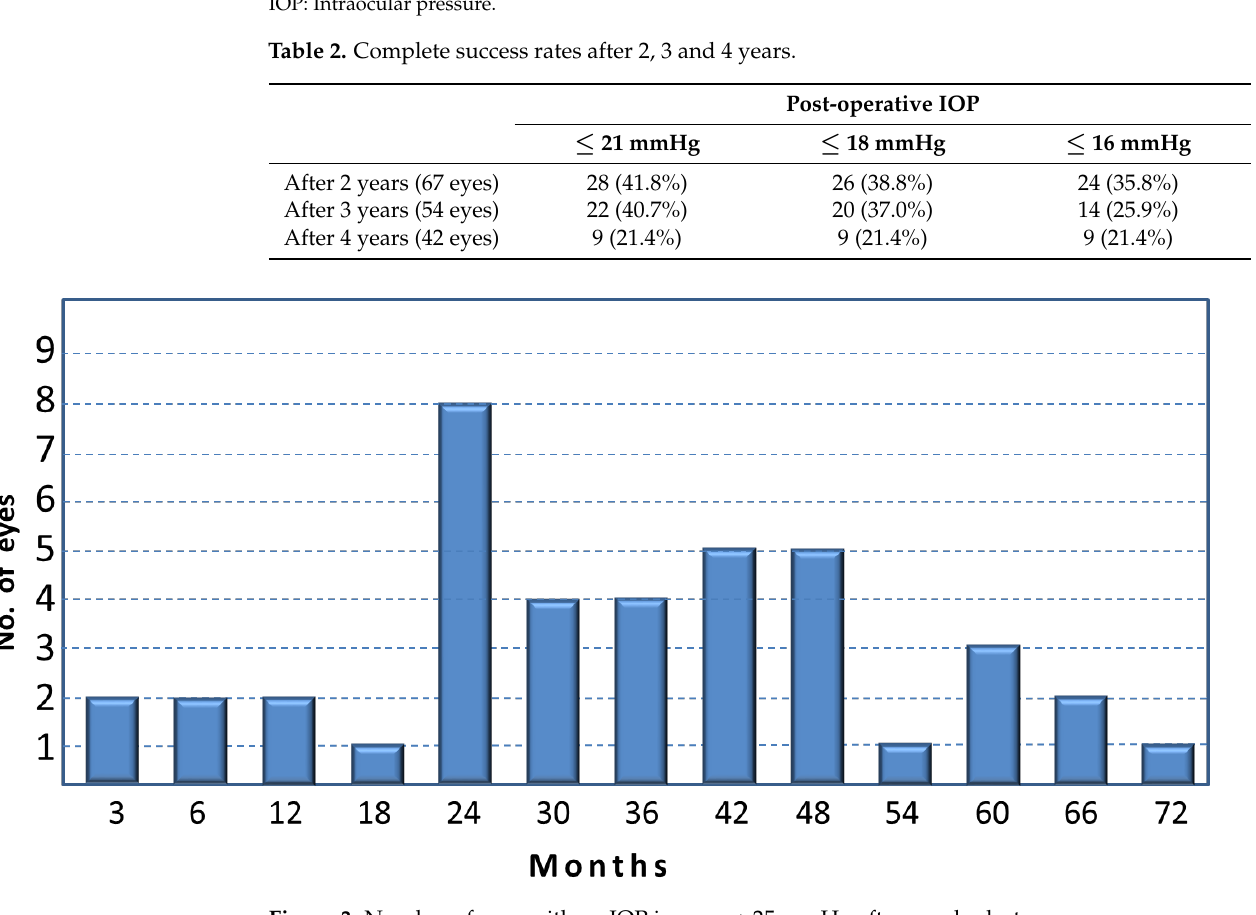
Figure 3. Number of eyes with an IOP increase >25 mmHg after